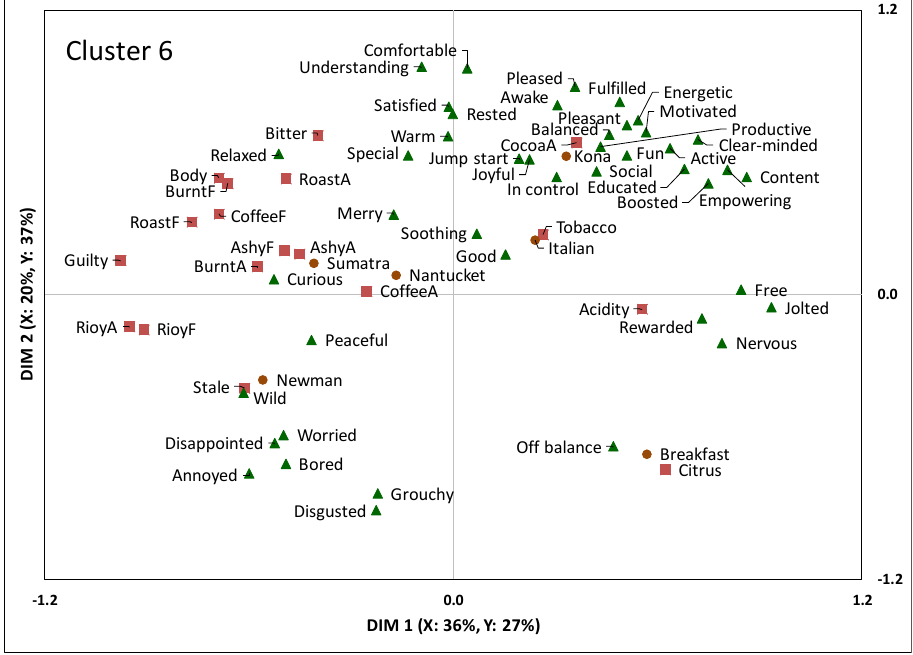
Figure 8. Partial least square regression analysis of descriptive sensory and CDE emotion lexicon of the six coffee samples for consumer Cluster 6.